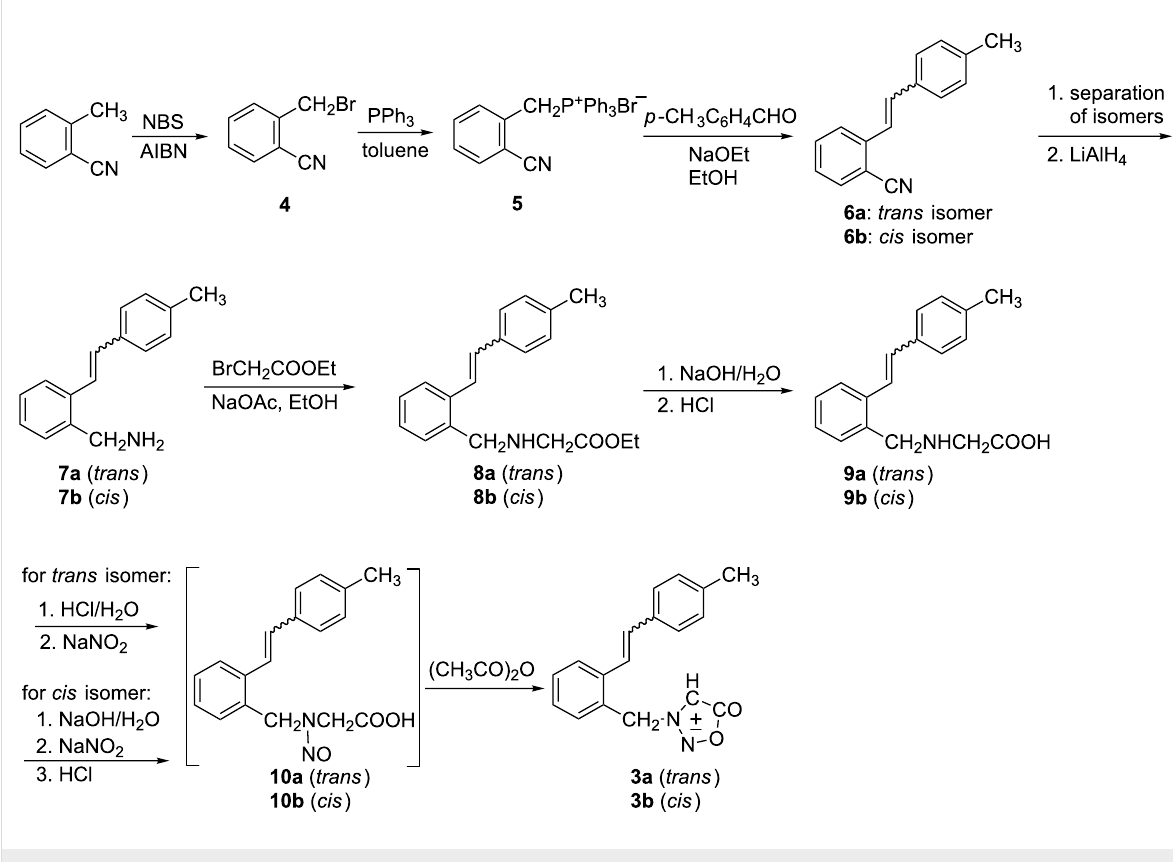
Scheme 2: Synthesis of the target molecules 3a and 3b